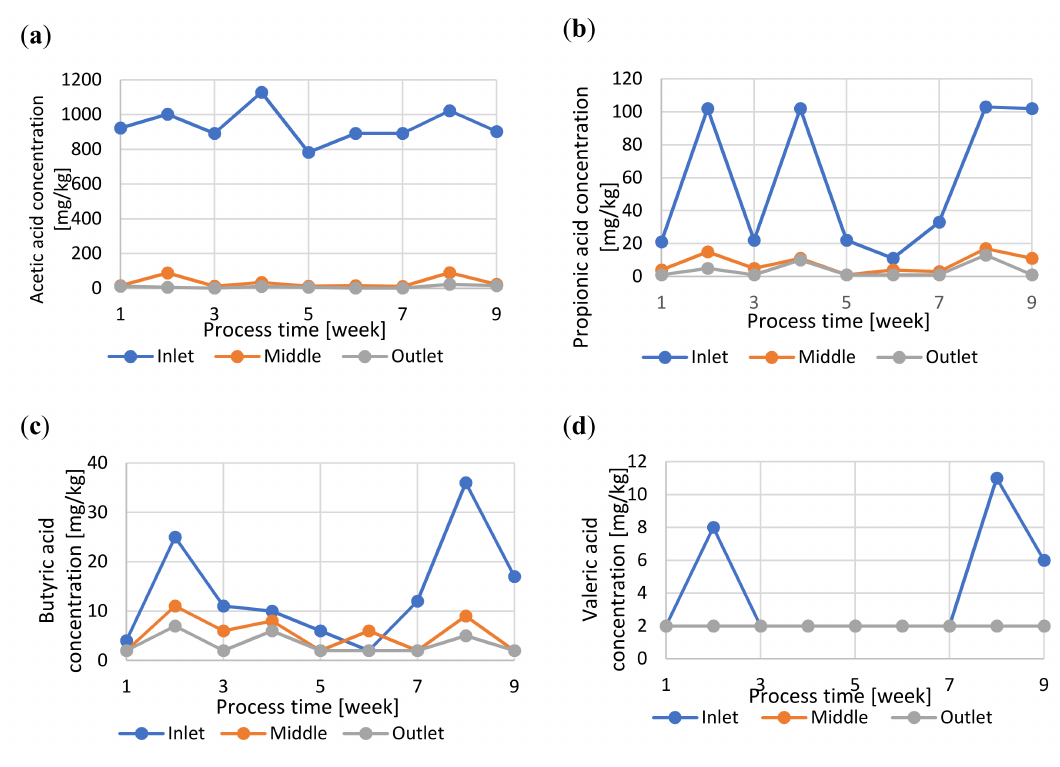
Figure 4. The changes in fatty acids concentrations during the anaerobic digestion in full-scale: ( a ) acetic acid; ( b ) propionic acid; ( c ) butyric acid; ( d ) valeric